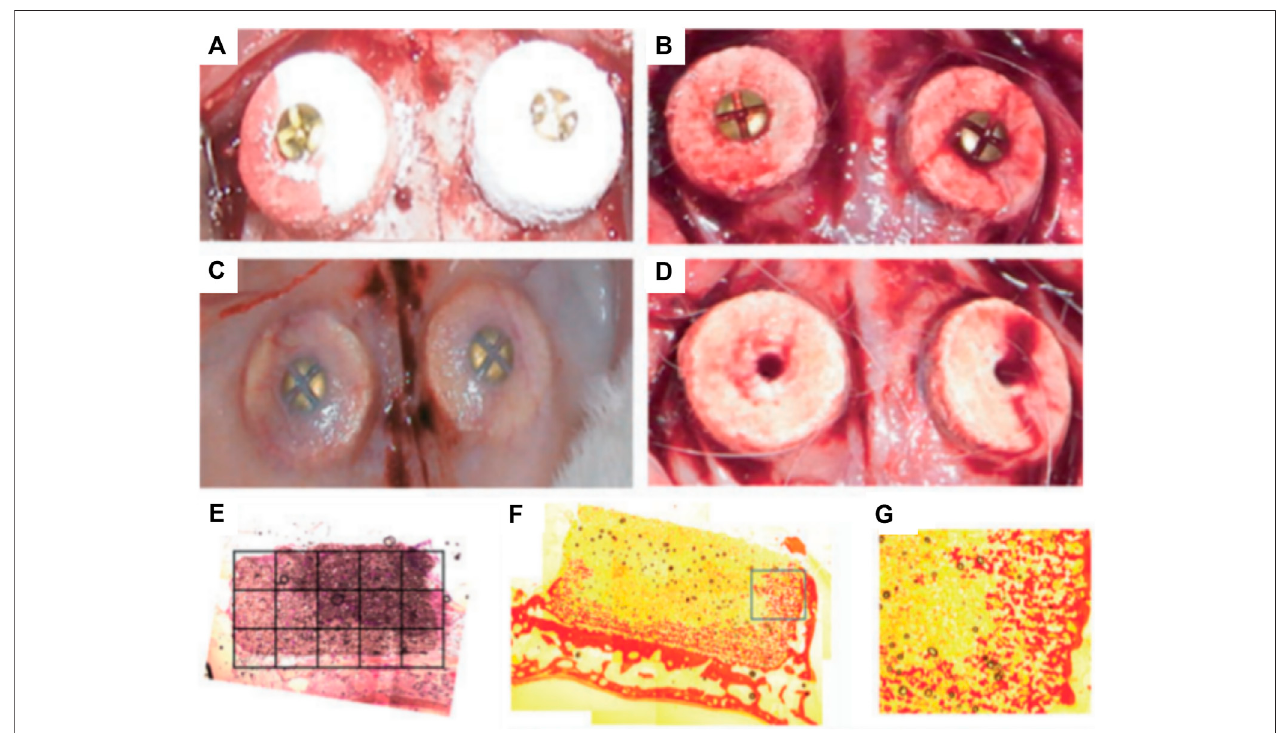
FIGURE 2 | In fl uence of overall height of 3D-powder printing monetite scaffold in a lapine extraskeletal model. (A) : 3 and 4 mm high 3D-printed scaffolds were implanted and fi xed using a fi xation screw, (B) : shows the blood clot stabilization within the scaffold immediately after implantation. (C) : Specimen morphology 8 weeks post-implantation. (D) :Removalofthe fi xationscrewsat8 weekspost-implantation, (E – G) :Tissuemorphologyasassessedbyhistology(picro-siriusstaining)indicating aheterogenousdistributionofthenewlyformedbonepreferentiallylocatedneartheresidentboneandattheperipheryofthescaffold.Reproducedwithpermission from (Torres et al.,